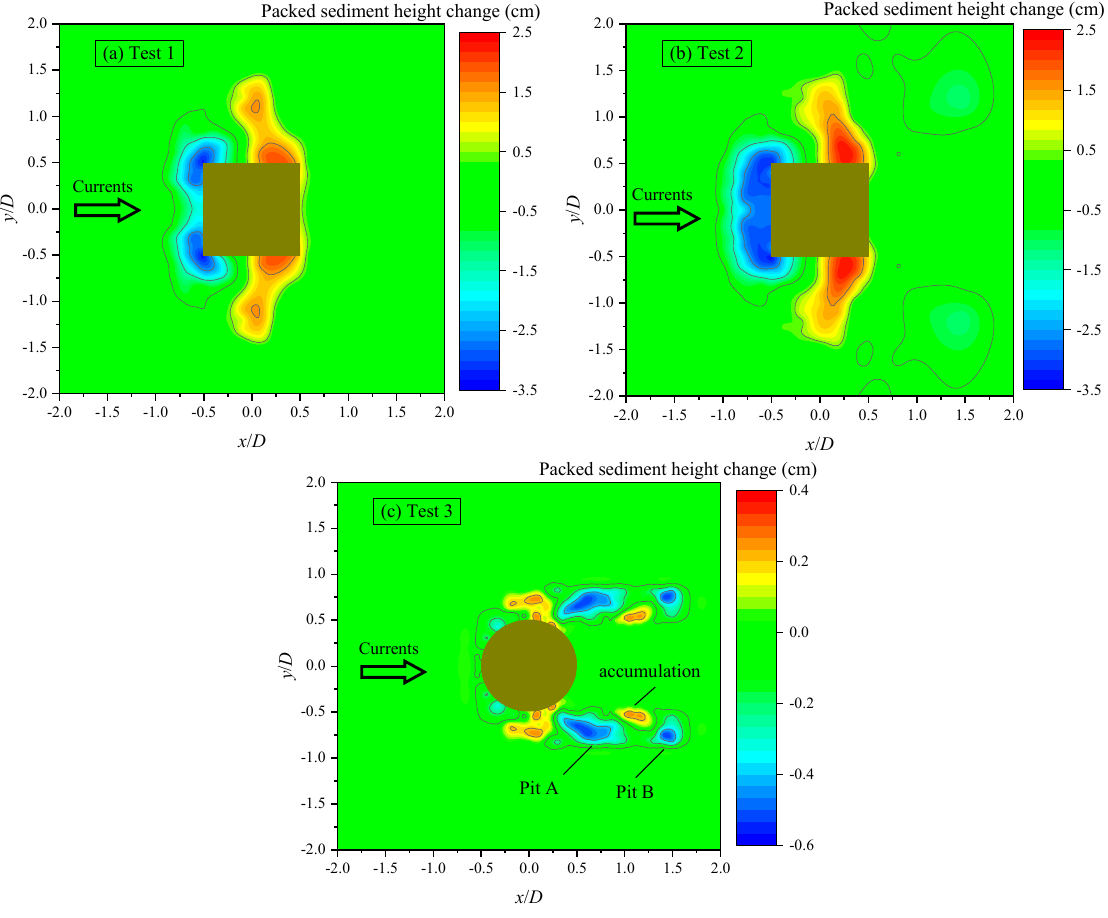
Figure 9. Contours of bed levels around the piles. ( a ) Test 1; ( b )Test 2; ( c ) Test 3.